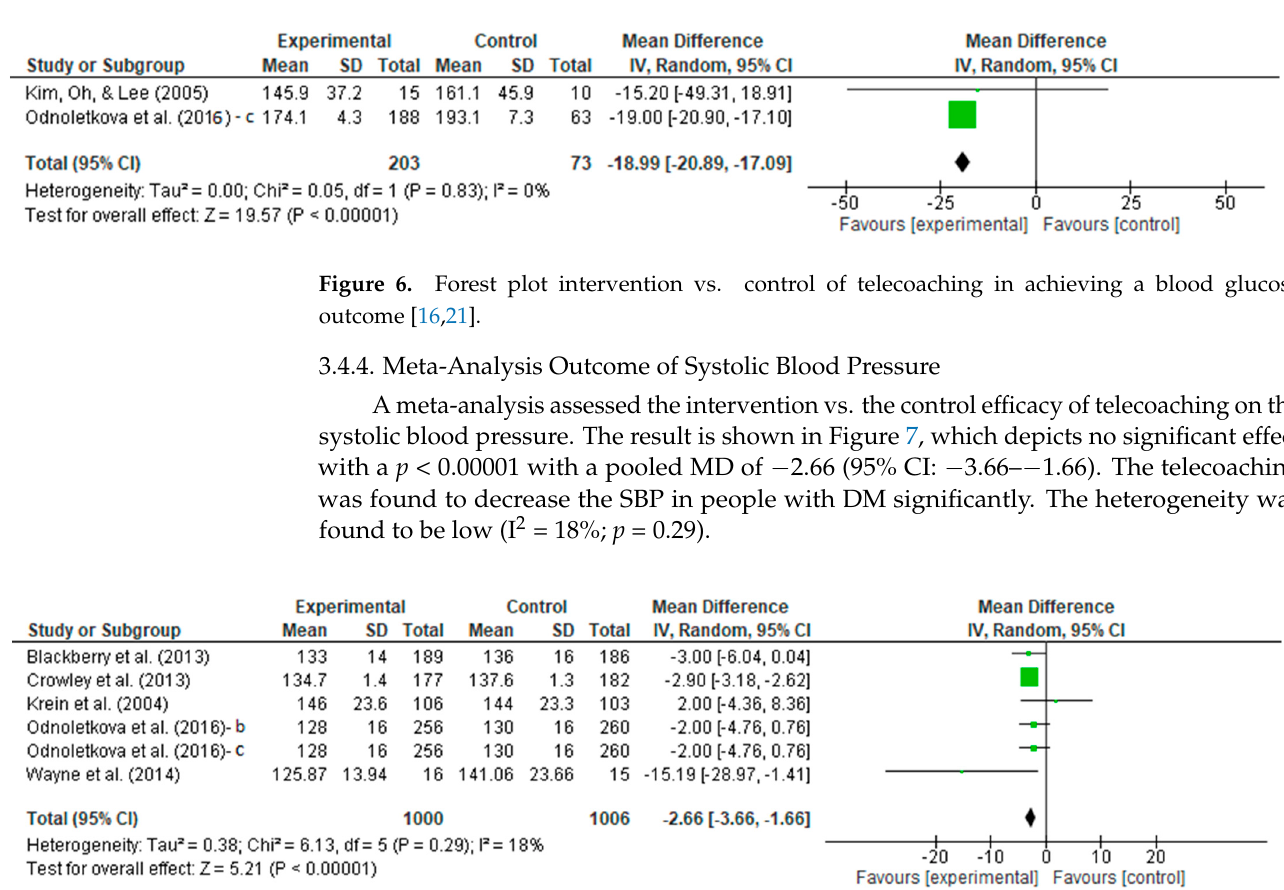
Figure 5. Funnel plot intervention vs. control of telecoaching in achieving a HbA1C outcome.